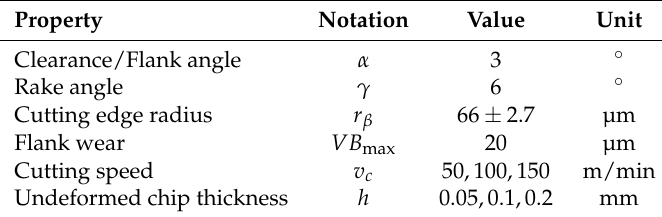
Table 2. Tool geometry and cutting parameters used in the simulations and experiments [36].